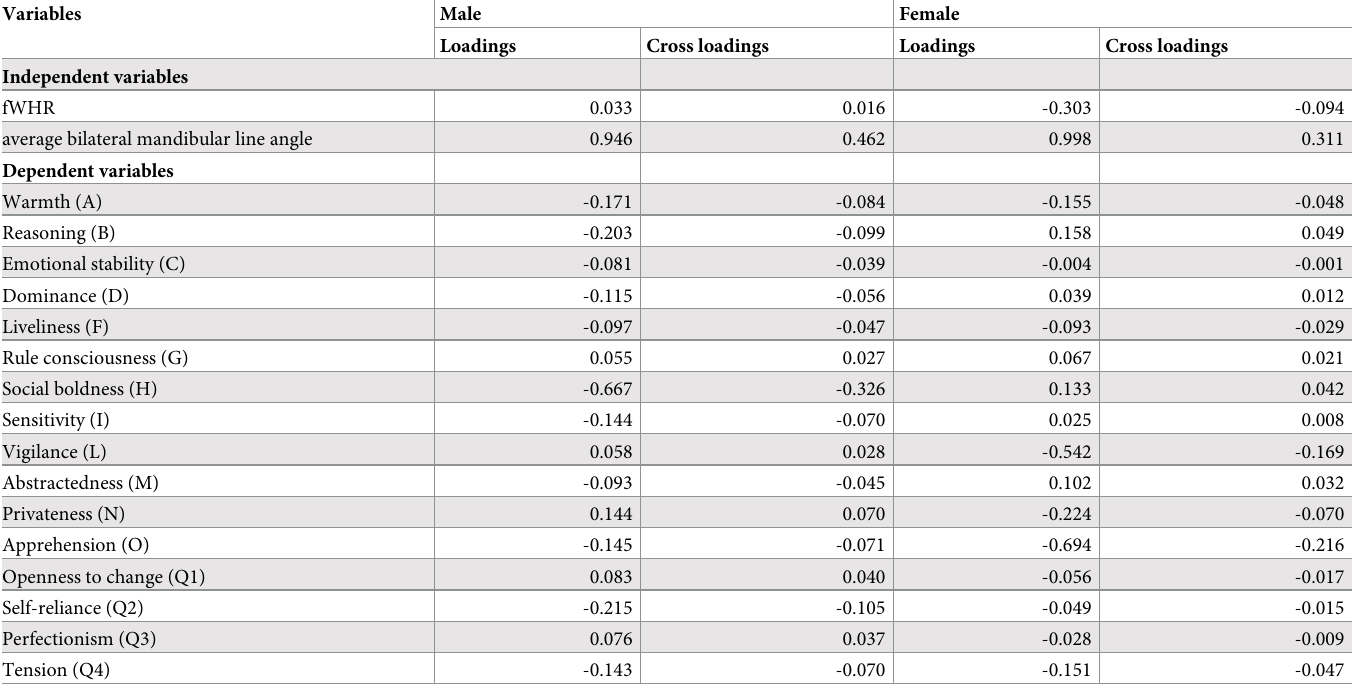
Table 3. Canonical weights, loadings and cross-loadings for the 1 st composite scores of the indicators of facial features and 16PF factors ( A-Q4 ) from 904 volunteers.